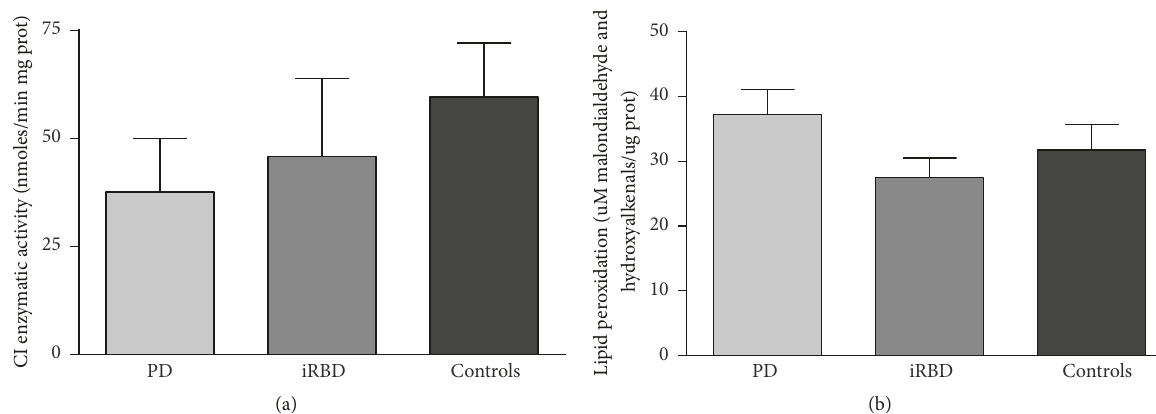
Figure 1: CI and lipid peroxidation assessment . (a) CI enzymatic activity of MRC. (b) Oxidative stress analysis through lipid peroxidation measured by malondialdehyde and hydroxyalkenal content. CI, complex I; MRC, mitochondrial respiratory chain; PD, Parkinson’s disease; iRBD, idiopathic REM sleep behavior disorder.